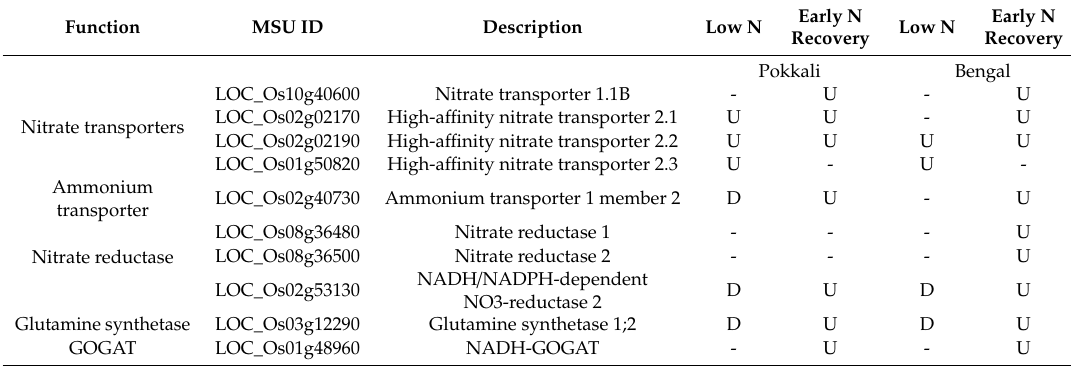
Table 3. Nitrogen uptake and metabolism-related DEGs of Pokkali and Bengal in response to low N and early (1-h) recovery conditions.